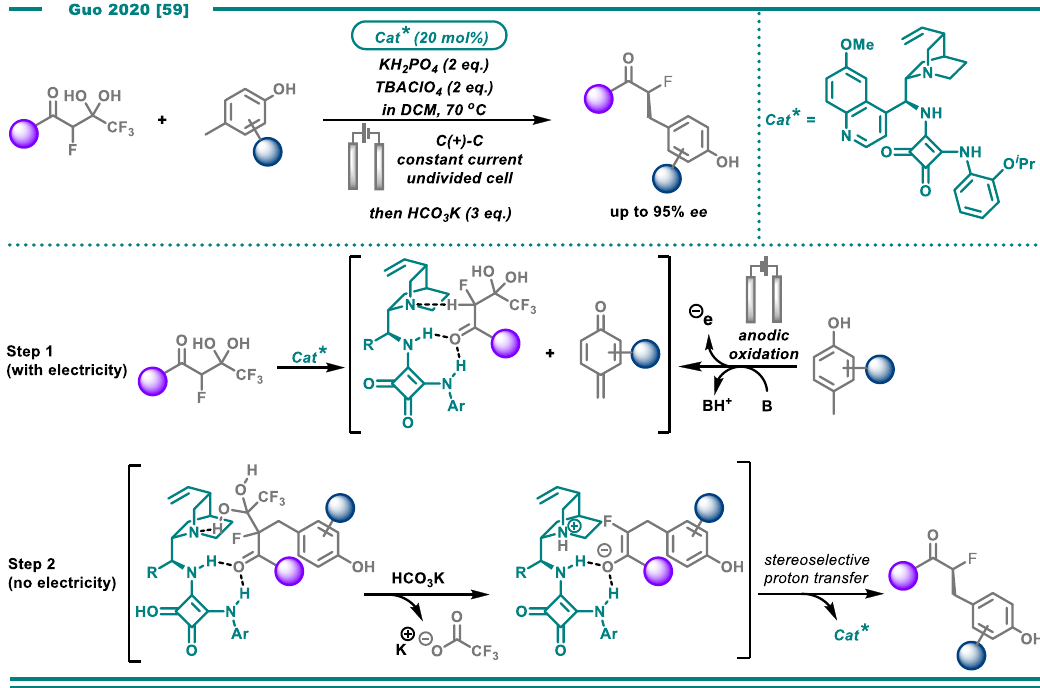
Scheme 8. Squaramide-catalyzed electrooxidative enantioselective α -benzylation / detrifluoroacetylation